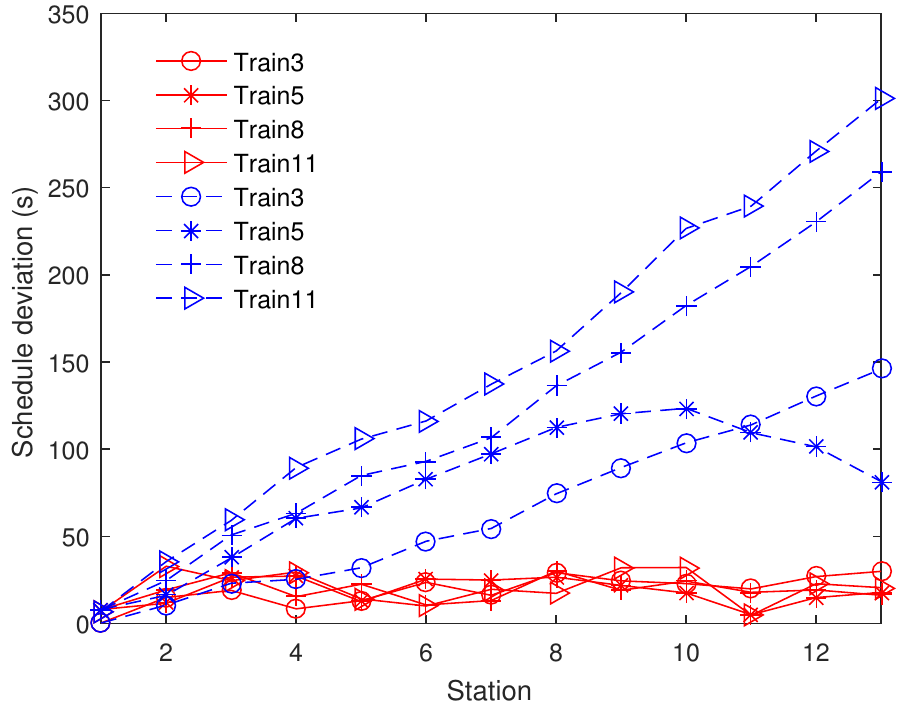
Figure 7. The schedule deviation comparison between Case 1 and Case 2 (dashed blue lines correspond to Case 1, and solid red lines correspond to Case 2).